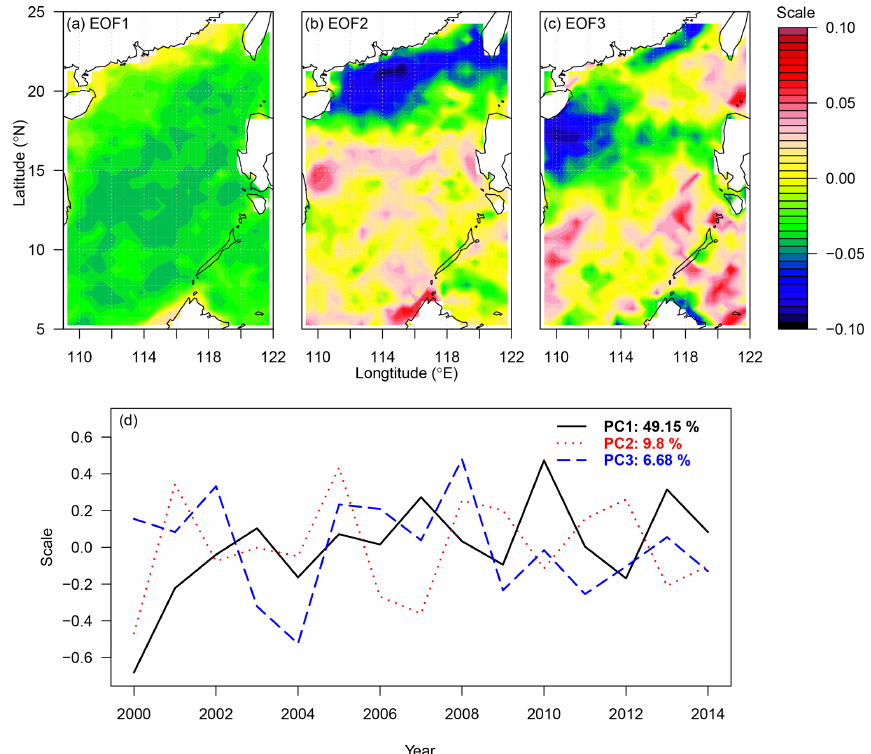
Figure 7. EOFs and PCs of the remote-sensing-derived p CO 2 estimates. (a–c) EOFs and (d) PCs.